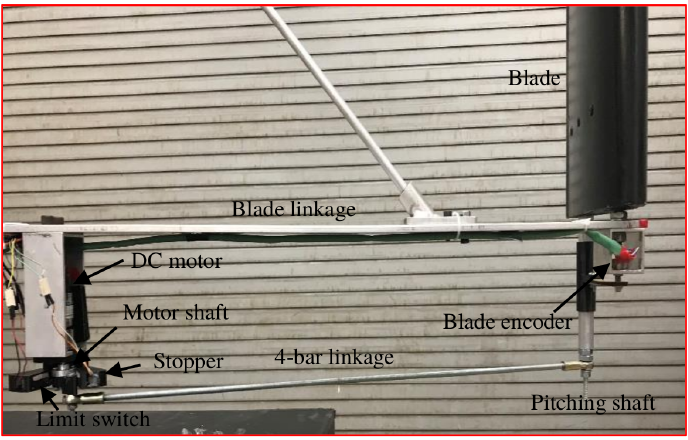
Figure 10. Pitch control system experimental